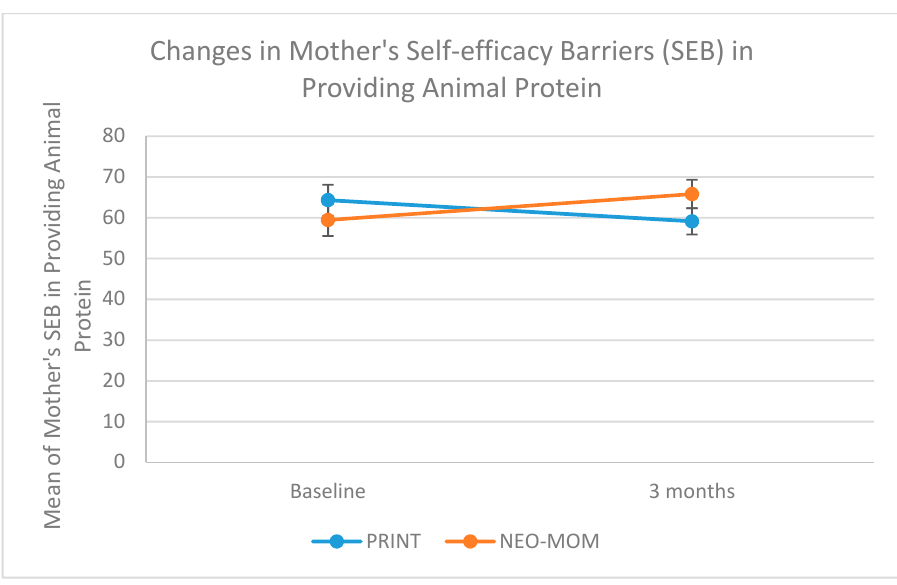
Figure 3 Profile plot of maternal self-efficacy (barriers) for providing animal protein.